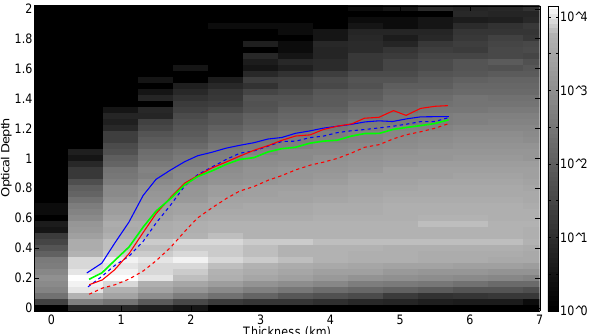
Fig. 7. Optical depth of geometrically homogeneous cirrus clouds is plotted as a function of mean cloud geometrical thickness for ML (blue) and tropics (red) and for day (solid line) and night (dashed line). The green line is the weighted mean of the red and blue curves and represents the mean of the whole Final Database. The curves are plotted above the frequency of occurrence (in grayscale) for the FD as function of ∆ z and τ .